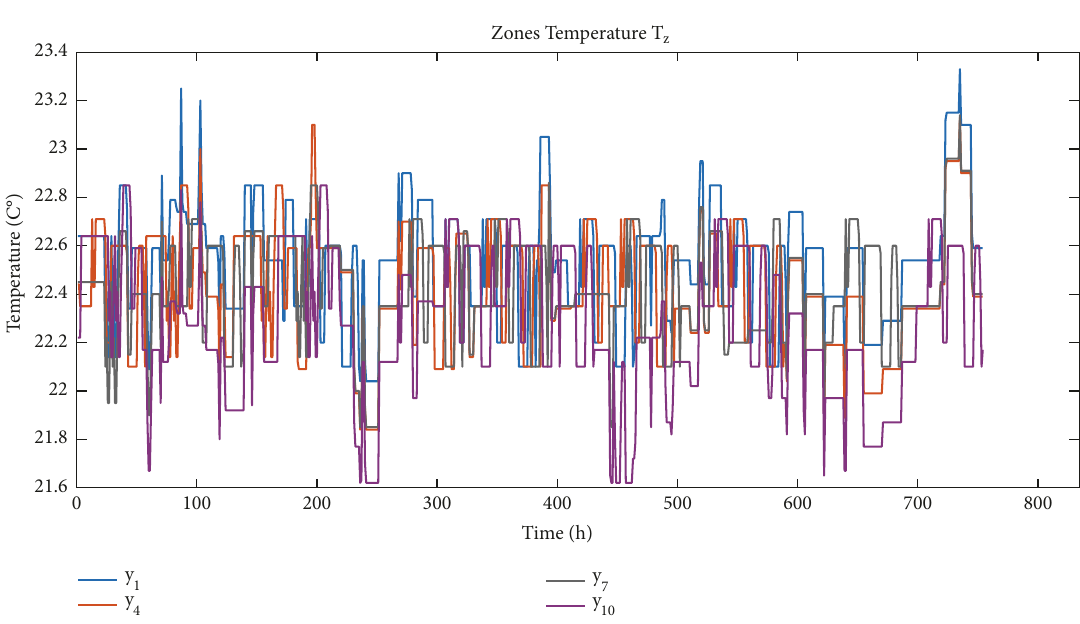
Figure 17: Zones